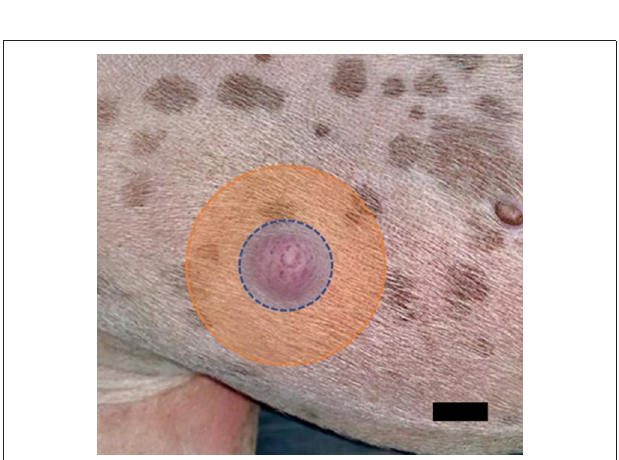
FIGURE 4 | Principle of treatment for mast cell tumors. First, the periphery should be treated (orange area), and then the tumor (blue area). Scale-bar